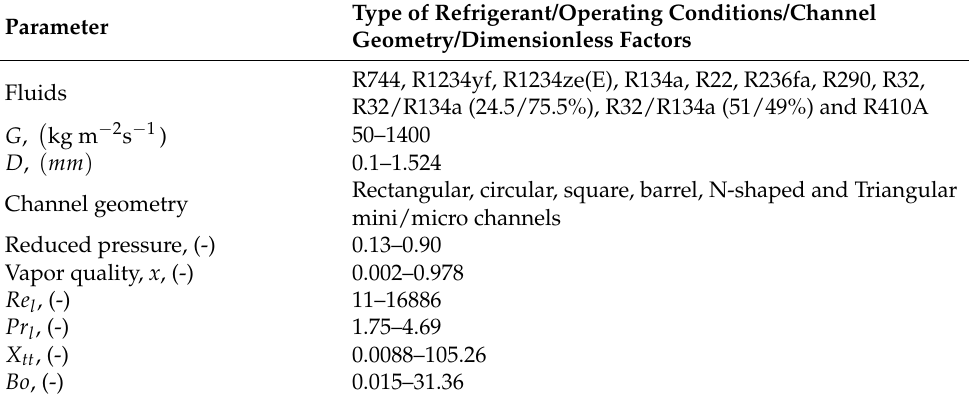
Table 2. Operating conditions, geometric dimensions, and the range of dimensionless factors used in the present